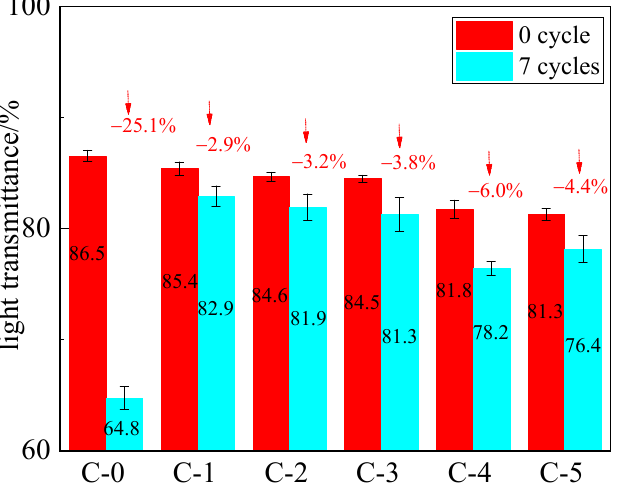
Figure 11. Light transmittance of the flame-retardant hydrogel before and after 7 aging cycles. The backside temperature curves of the samples after 7 aging cycles are illustrated in Figure 12, and the back temperature data is given in Table 2.